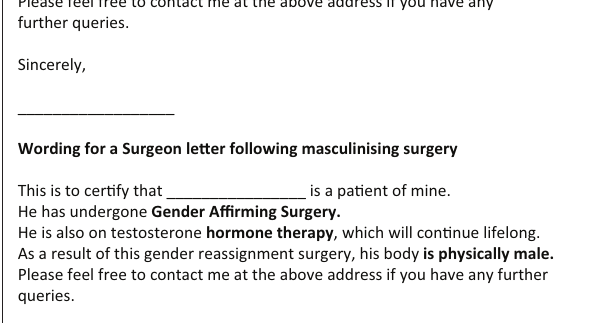
FIGURE 2-A1: Suggested letter in support of application to Department of Home Affairs for change in gender marker – surgeon (following feminising surgery).